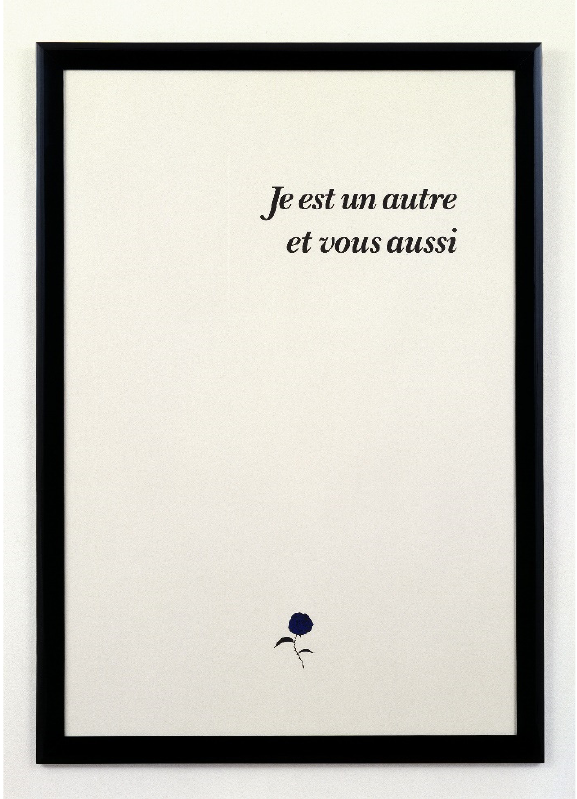
Figure 7. Jan Vercruysse, Je , 1990. Two colour offset printing on Moulin de Gué paper. 95 × 65 cm. © Jan Vercruysse Foundation. Reprinted with permission from Jan Vercruysse